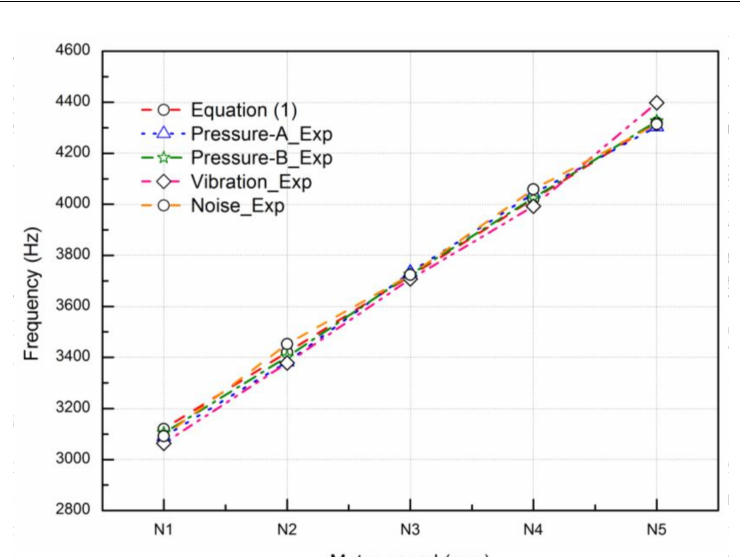
Figure 12. Comparison of the primary frequencies between the calculated and experimental results for the Type A flapper-armature assembly.